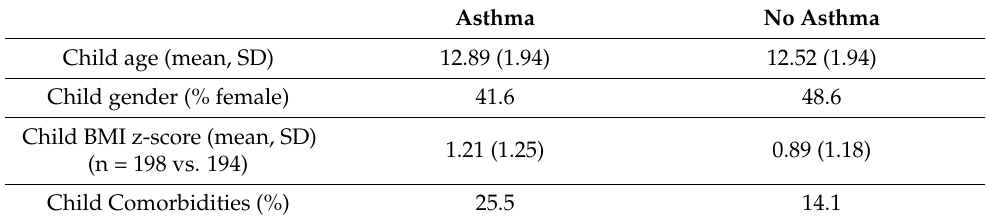
Table 2. Child characteristics.